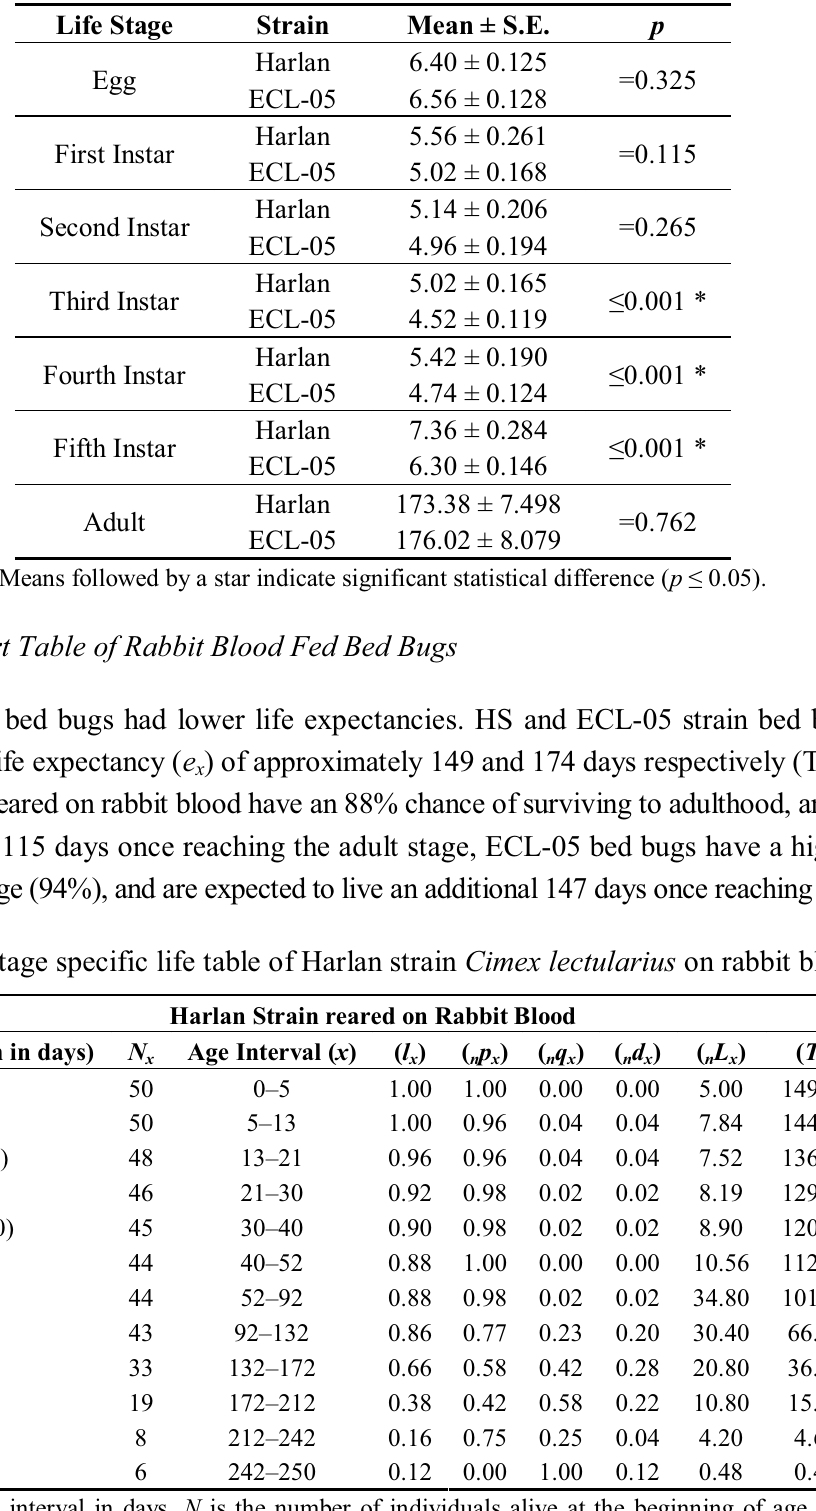
Table 3. Mean development time (in days) of human blood reared Harlan and ECL-05 strains.